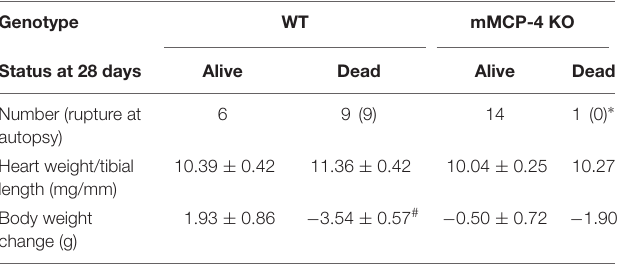
TABLE 1 | Mouse survival and weight changes after